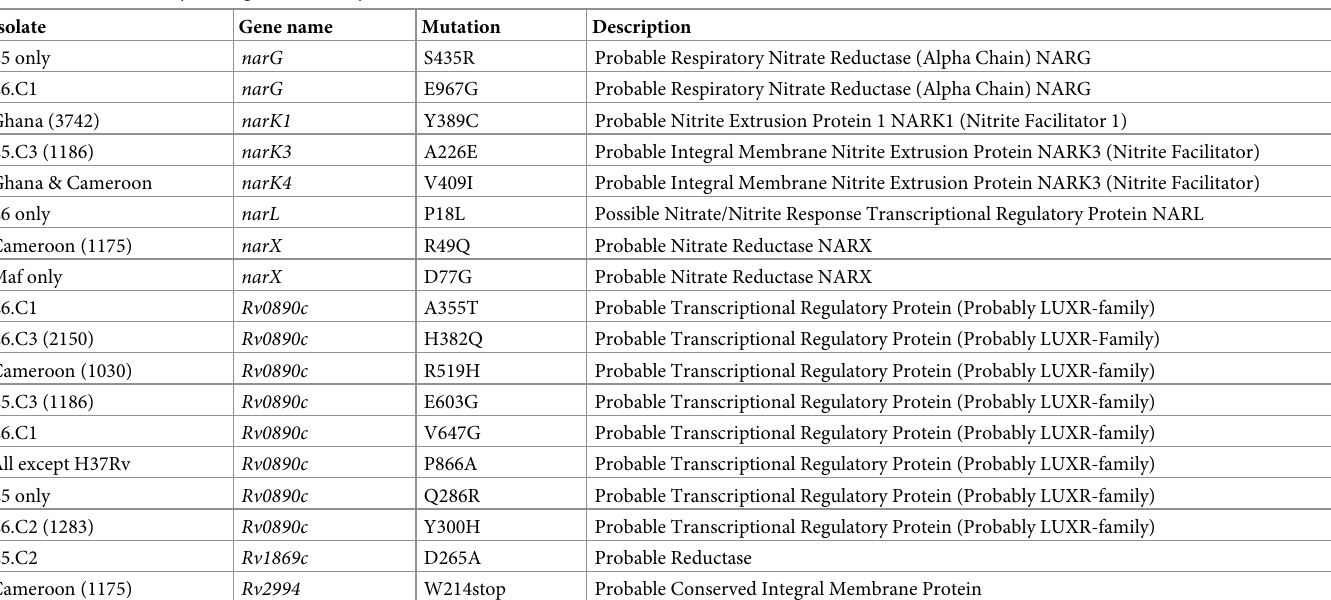
Table 3. Genomic analysis for genes that may be involved in nitric oxide. Isolate